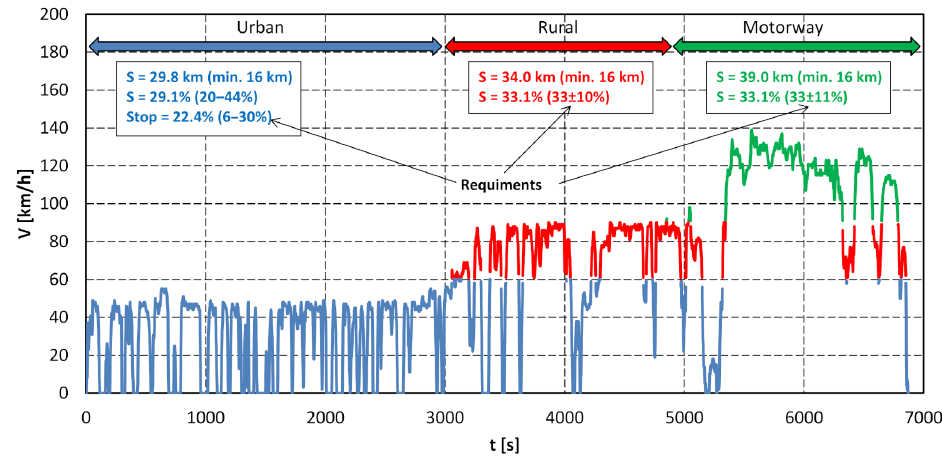
Figure 4. Course of the RDC test with characteristics phases (S = 102.8 km, t = 114.5 min).